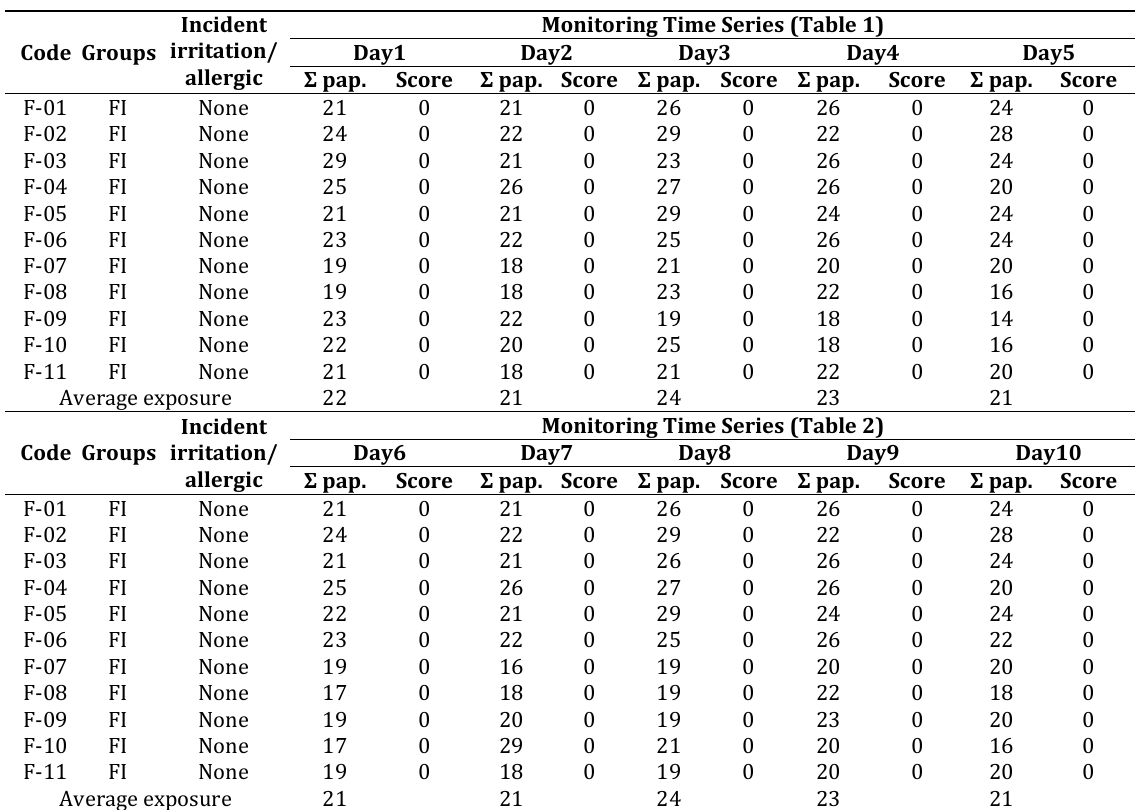
Table VIII Monitoring time series exposure on Induction-Follow-up group Code